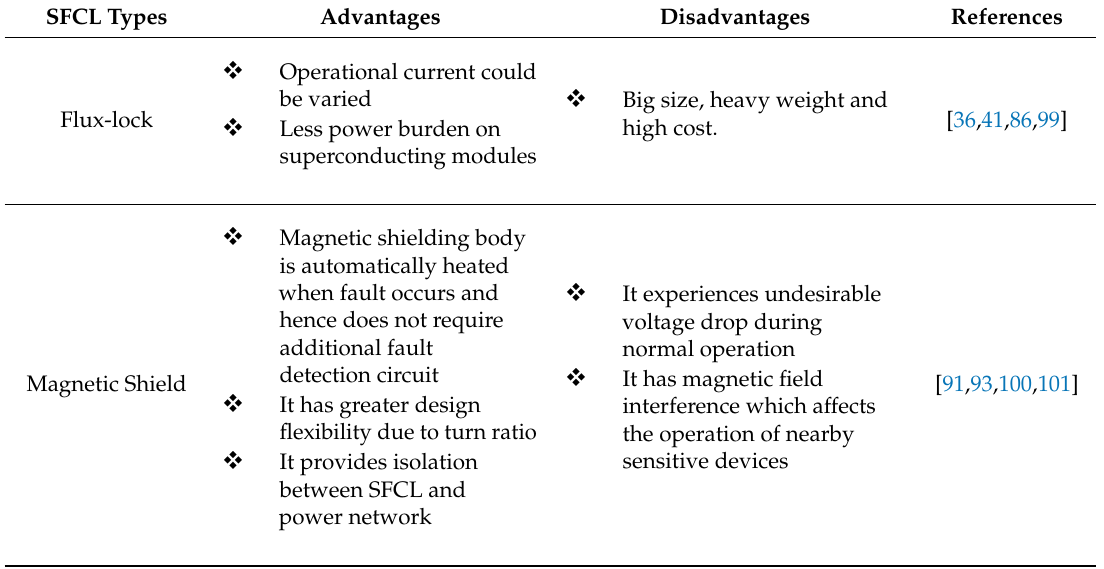
Figure 4. The phases for implementing a N-AHP in SWOT analysis.